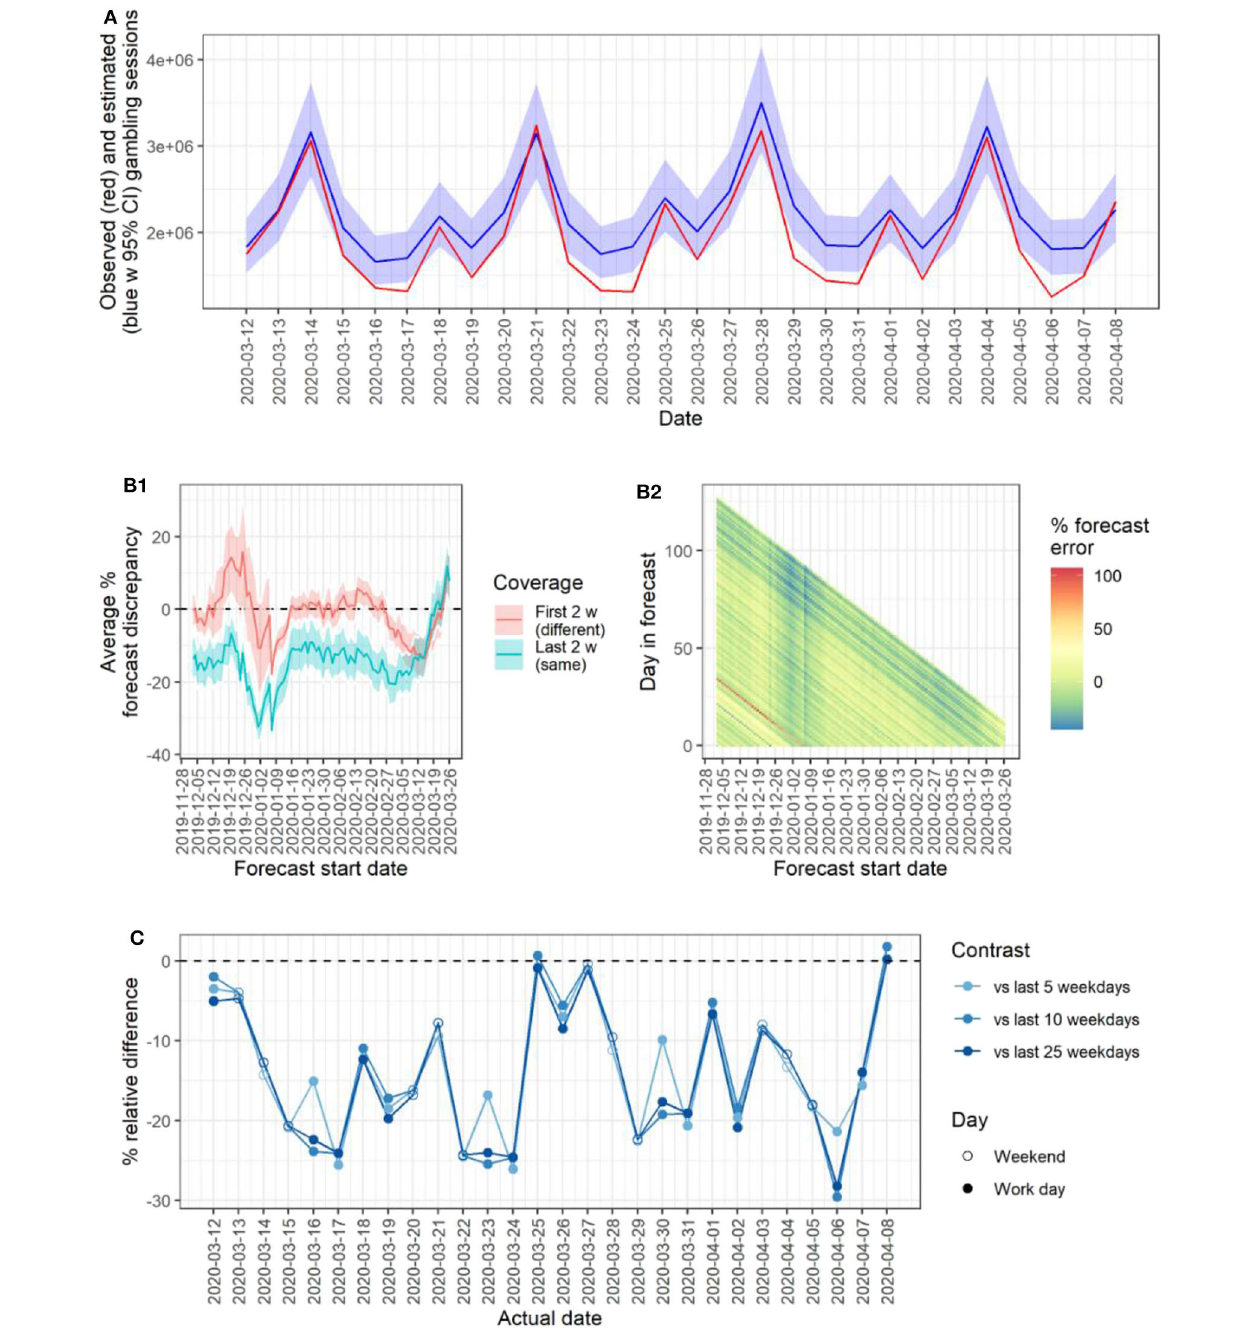
FIGURE 2 | Observed gambling activity vs. time series forecast reference and point-estimate references. (A) Time series of observed (red) and forecasted (blue, with 95% CI) gambling activity during the evaluation period following the first COVID-19 death in Sweden. (B1) Expanding window analysis indicating forecast performance and sensitivity (respectively) by plotting period-average forecast discrepancy (dates group by week). (B2) Plot of forecast discrepancy for all dates and expanding window models (dates grouped by week). (C) Decrease relative to references points drawn from 5, 10, and 25 weeks (respectively) of same weekdays prior